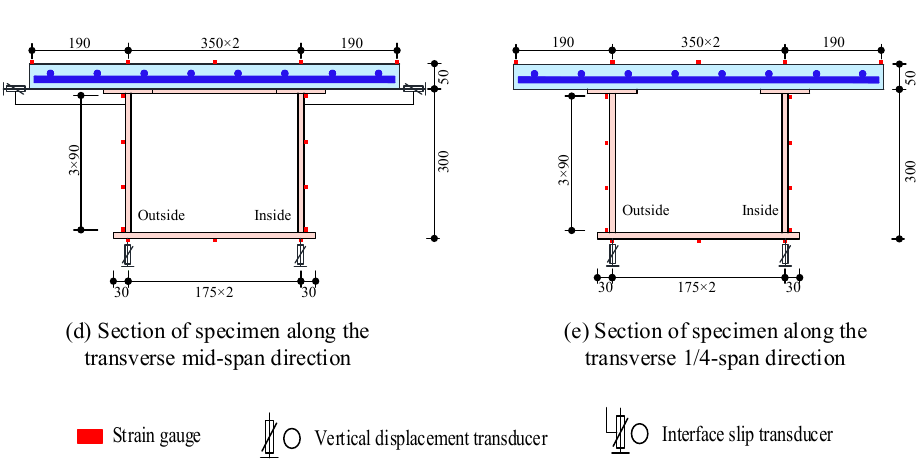
Figure 5. Measurement of CCB-1 (in units of mm).